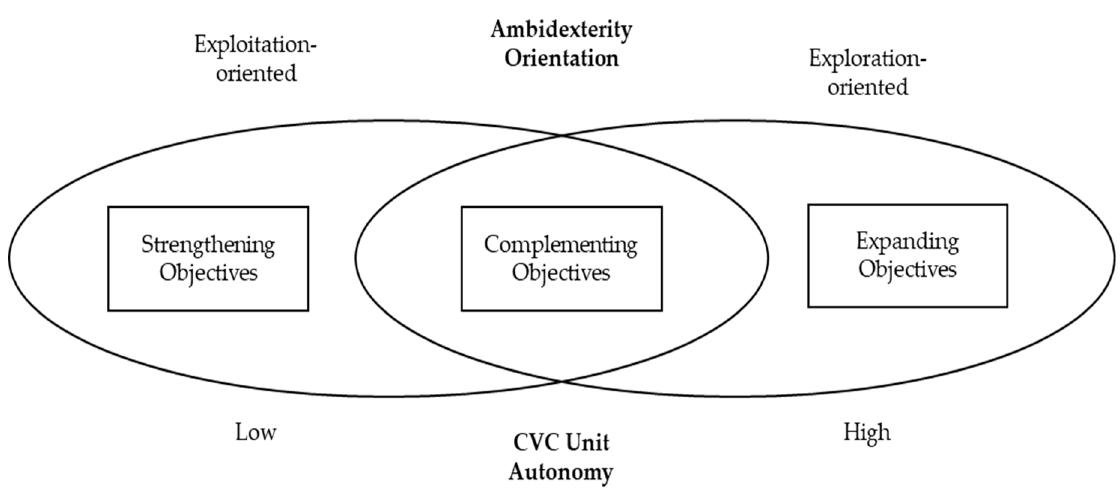
Figure 2. Framework on Strategic Objectives of Corporate Venture Capital, Ambidexterity and Autonomy of the CVC Orientation and Autonomy of the CVC Unit.